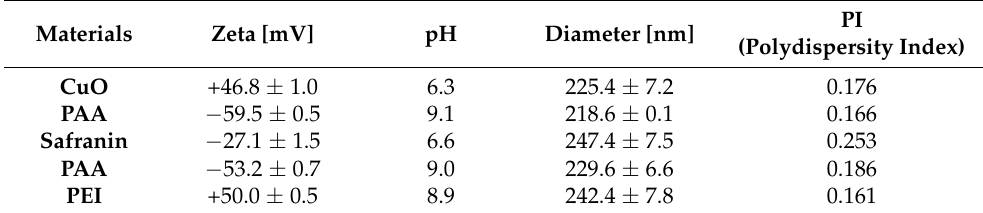
Figure 3. Zeta potential of CuO based nanocontainers in dependence on the layer number of polymers and entrapped Safranin ( A ). Hydrodynamic diameters of the nanocontainers ( B ). (* - ordinary CuO). Table 1. Characterization of CuO nanocontainers with